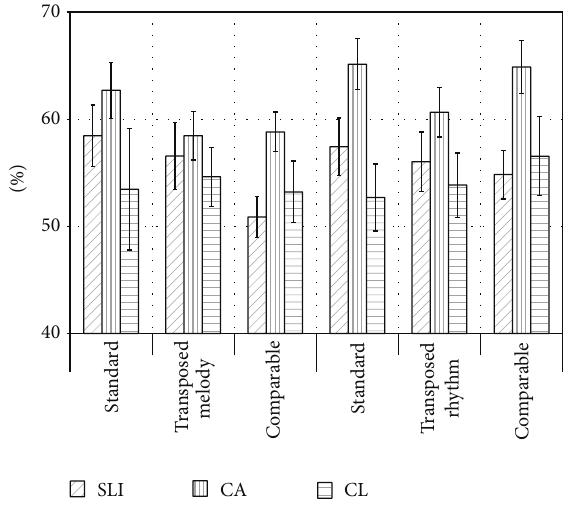
Figure 3: Mean percentage of correct responses (and standard error of mean) for the subtests of the melodic (left panel) and the rhythmic-melodic perception tasks (right